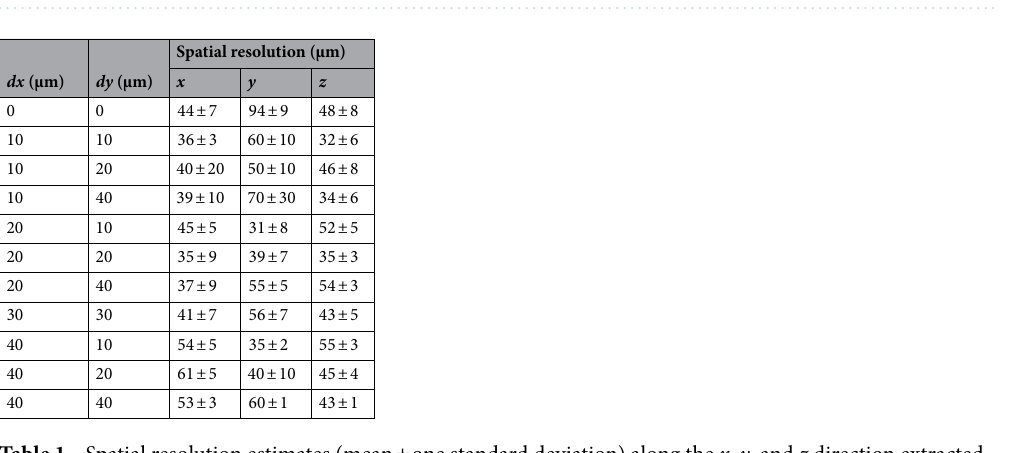
Figure 2. Sampling grids (shown only for a single mask period in the horizontal, p x , and vertical, p y , direction) for a dithered scan ( a ), a rotation-only scan ( b ), and a cycloidal-spiral scan ( c ). In the former case, the sample is scanned in horizontal and vertical steps of Δ x opt = p x /8 and Δ y opt = p y /8, respectively, at each rotation angle. In the latter case, the sample is displaced by horizontal and vertical (sub-period) distances of dx = Δx opt and dy = 4 Δy opt , simultaneously with being rotated to the next angle.